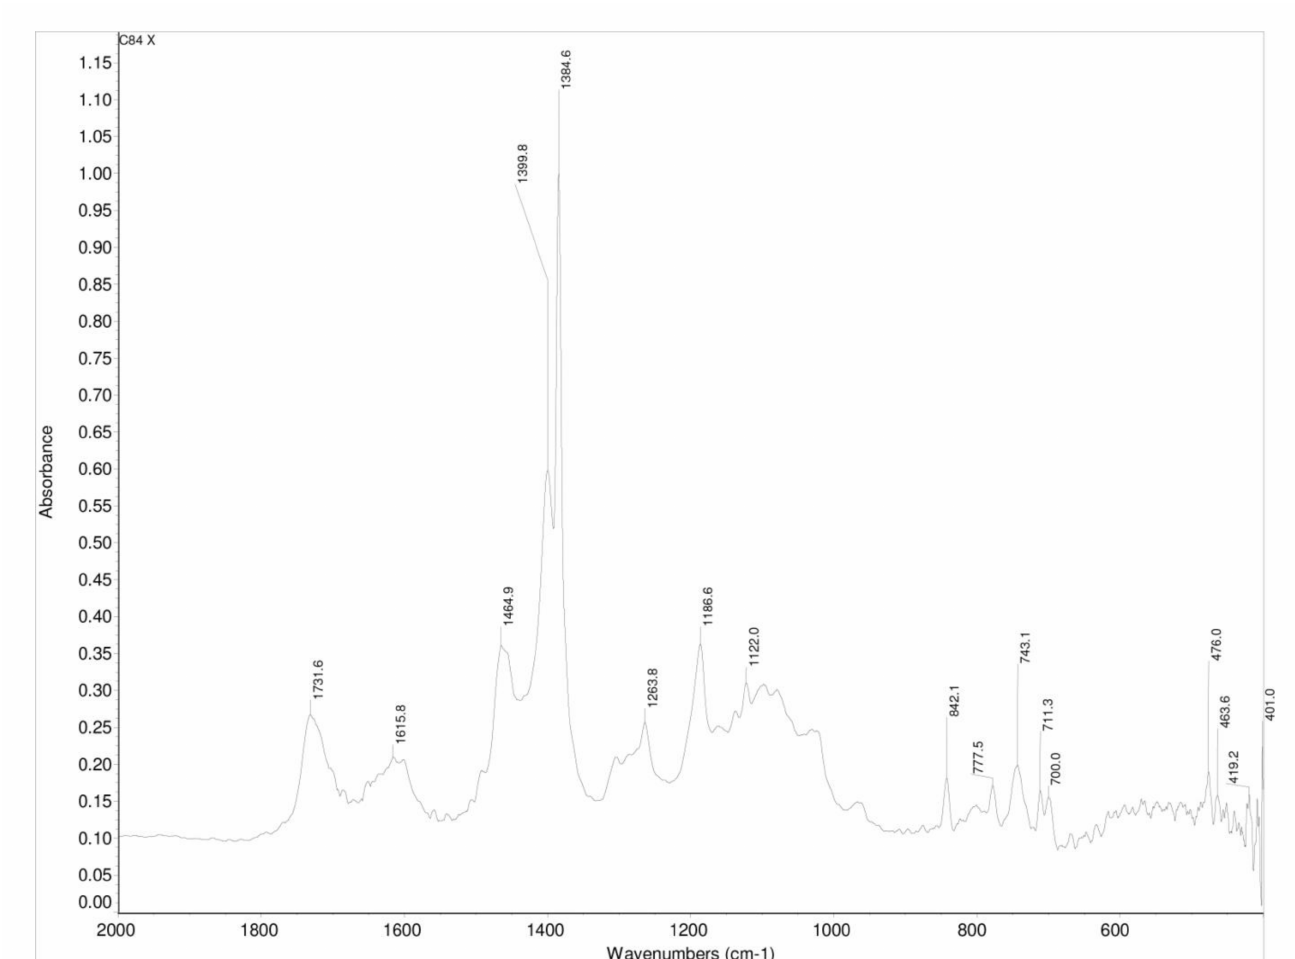
Figure 1. The infrared spectrum of the C 84 -D 2 :22 sample, isolated in the original, advanced processes [36], recorded on a Thermo Scientific FT-IR spectrometer, in the absorption